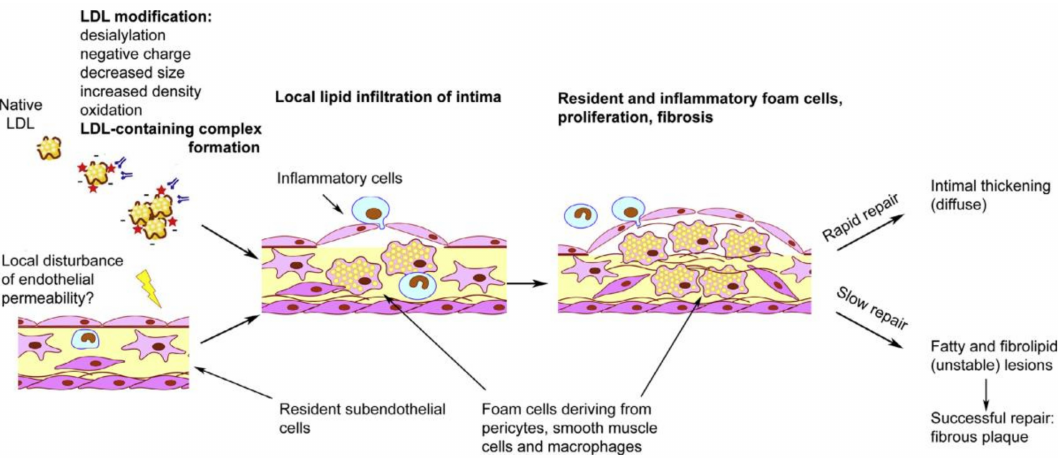
Figure 6. Schematic overview of initiation of atherosclerotic lesion formation. Adopted from [40], with